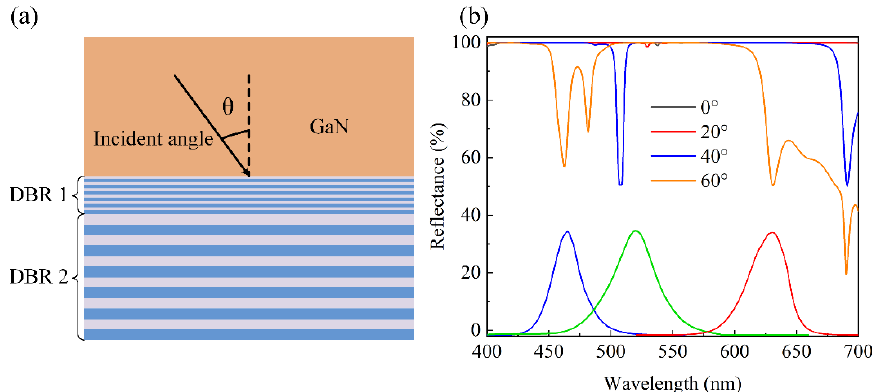
Figure 2. ( a ) Schematic illustration of double-stack DBR structure. ( b ) Reflectance spectra of the double-stack DBR as a function of incident angle.